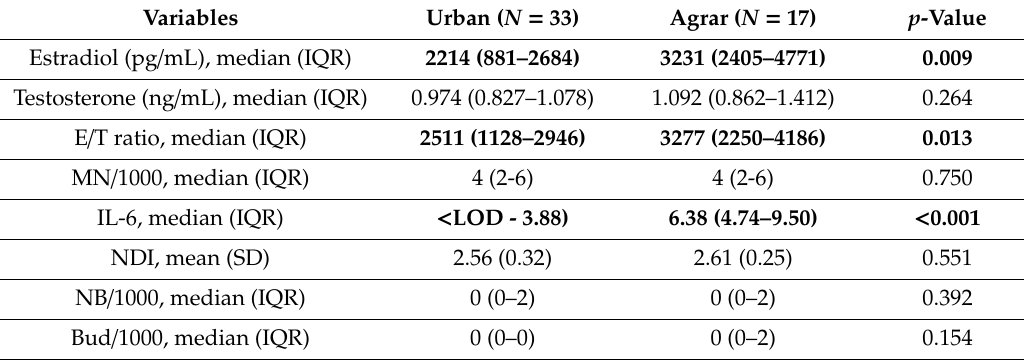
Table 2. Di ff erences in newborns’ hormone levels, IL-6, and markers of genome damage ( N = 50) by type of